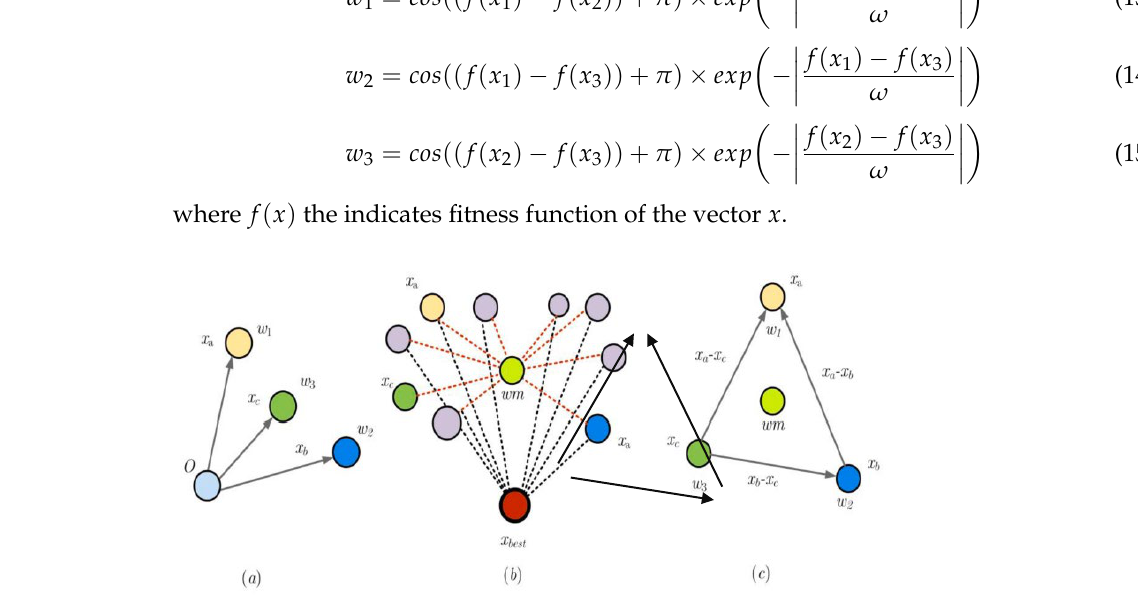
Figure 6. The weighted mean of three vectors. ( a ) three vectors ( b ) differences between them ( c ) weighted mean of them. ( c ) weighted mean of